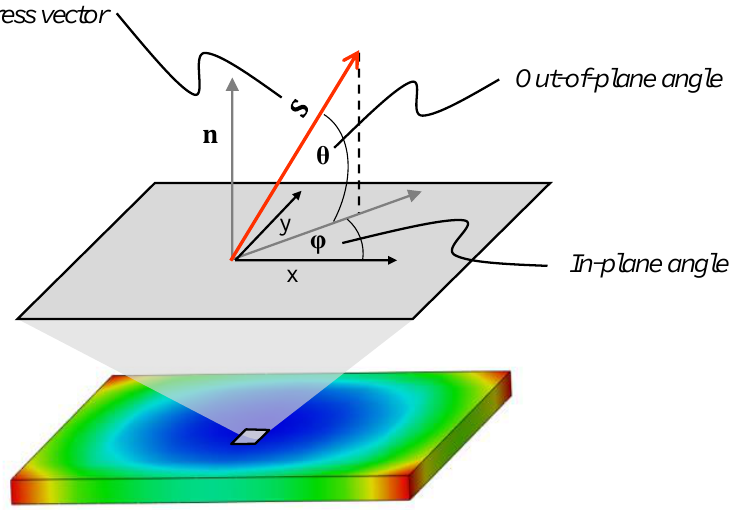
Figure 5. Decomposition of the stress vector S into an in-plane angle (phi) and out-of-plane angle (theta).